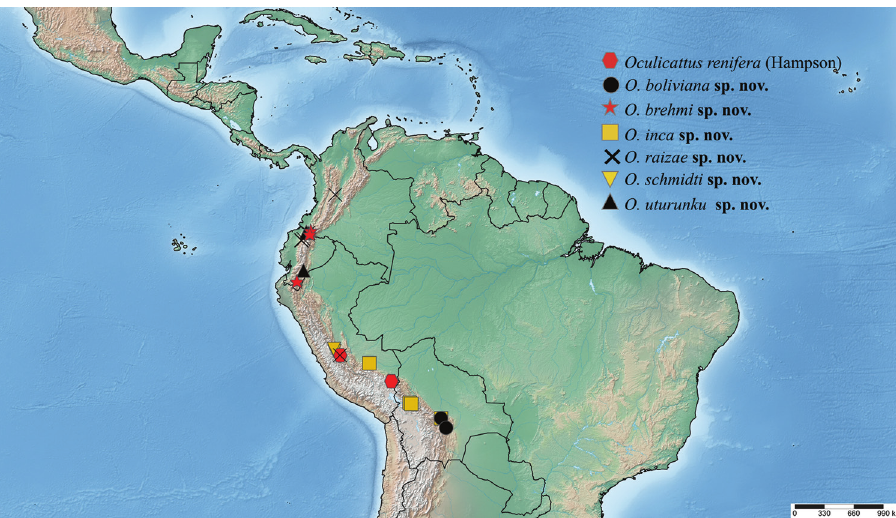
Figure 95. Distribution of examined specimens of the genus Oculicattus